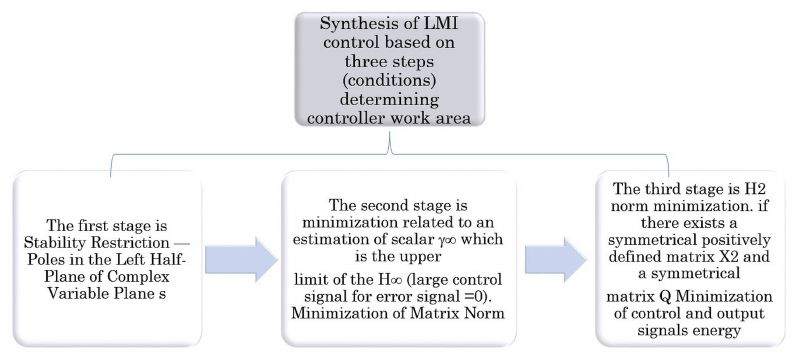
Figure 5. First stage of autonomous ship control. Synthesis of the low speed